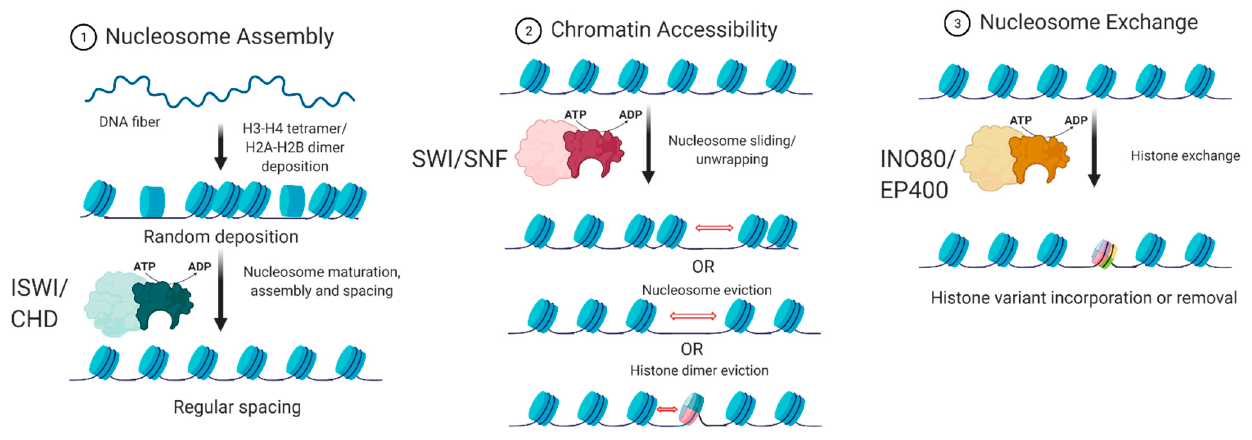
Figure 4. The biochemical functions of ATP-dependent chromatin remodelers. Adapted from [25].